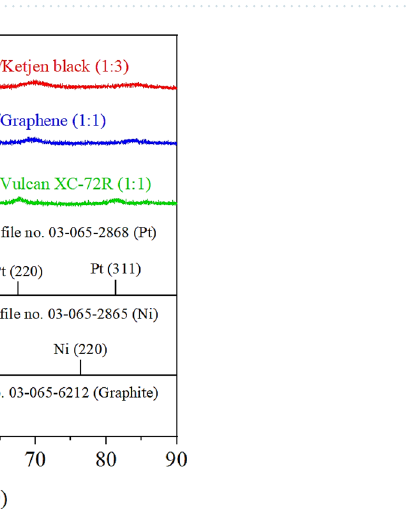
Figure 4. The high-resolution TEM pictures of Pt 3 Ni nanoparticles on each carbon support that demonstrated the highest ORR activity: ( a ) Pt 3 Ni/Ketjen black (1:3), ( b ) Pt 3 Ni/Graphene (1:1) and ( c ) Pt 3 Ni/Vulcan XC-72R (1:1).